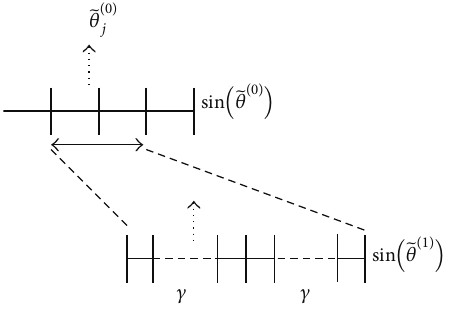
Figure 1: Illustration of grid refinement.